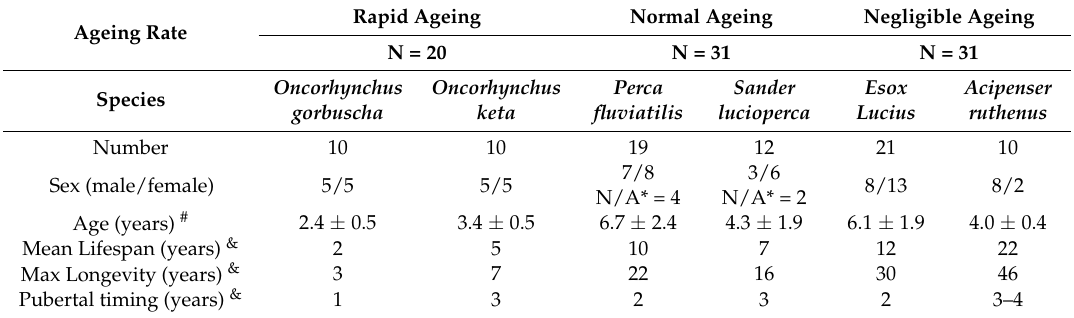
Table 2. Characteristics of the analyzed fish groups of Oncorhynchus gorbuscha, Oncorhynchus